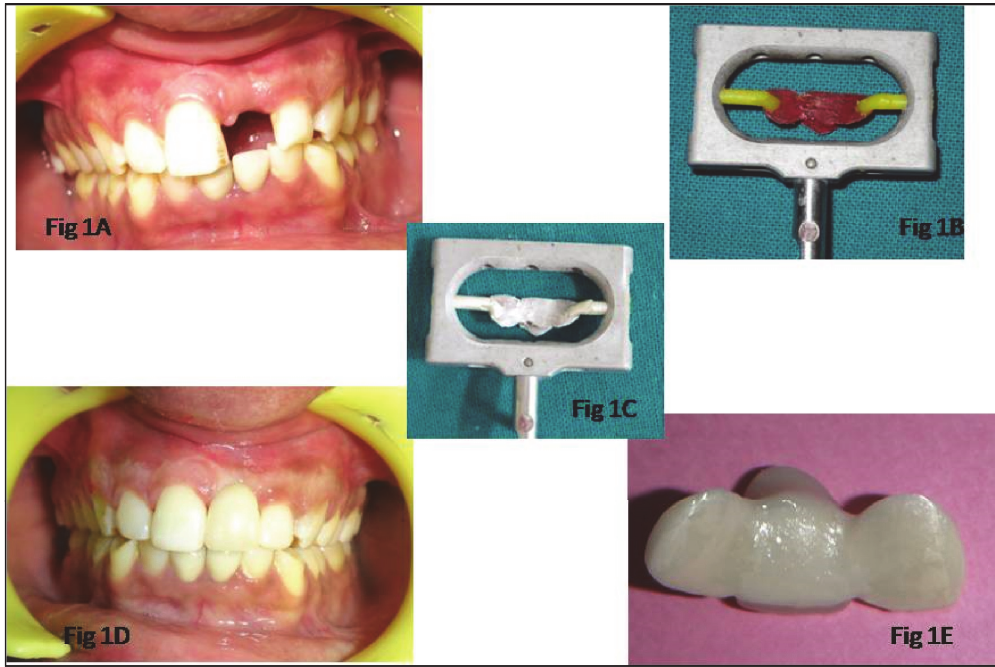
Figure 1: Missing central incisor restored with copy-milled all-ceramic Maryland Bridge. (A) Preoperative photograph showing missing left central incisor. (B) Pattern resin attached to scan holder. (C) Scan spray on pattern resin. (D) Maryland Bridge cemented. (E) Maryland Bridge framework veneered with ceramic.